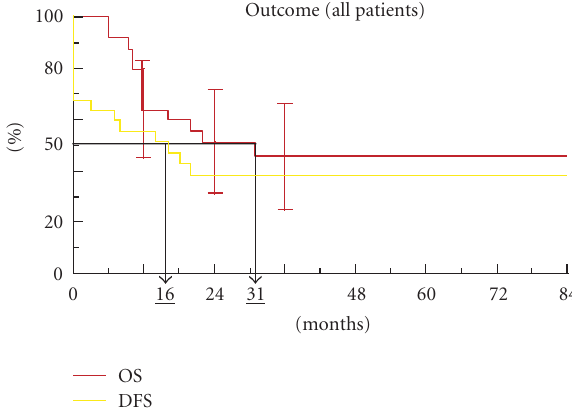
Figure 1: Overall survival and disease-free survival (OS,